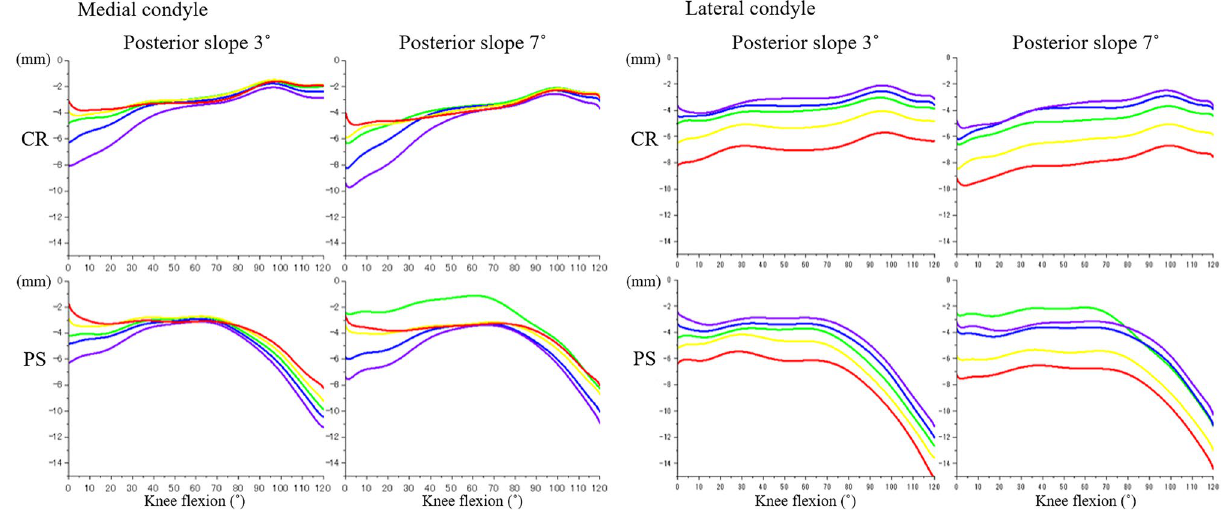
Figure 3. Condylar rollback of femoral component during knee flexion. CR cruciate-retaining design, PS posterior-stabilized design. Comparison between the tibial rotational alignments (red: internal 10°, yellow: internal 5°, green: neutral, blue: external 5°, purple: external